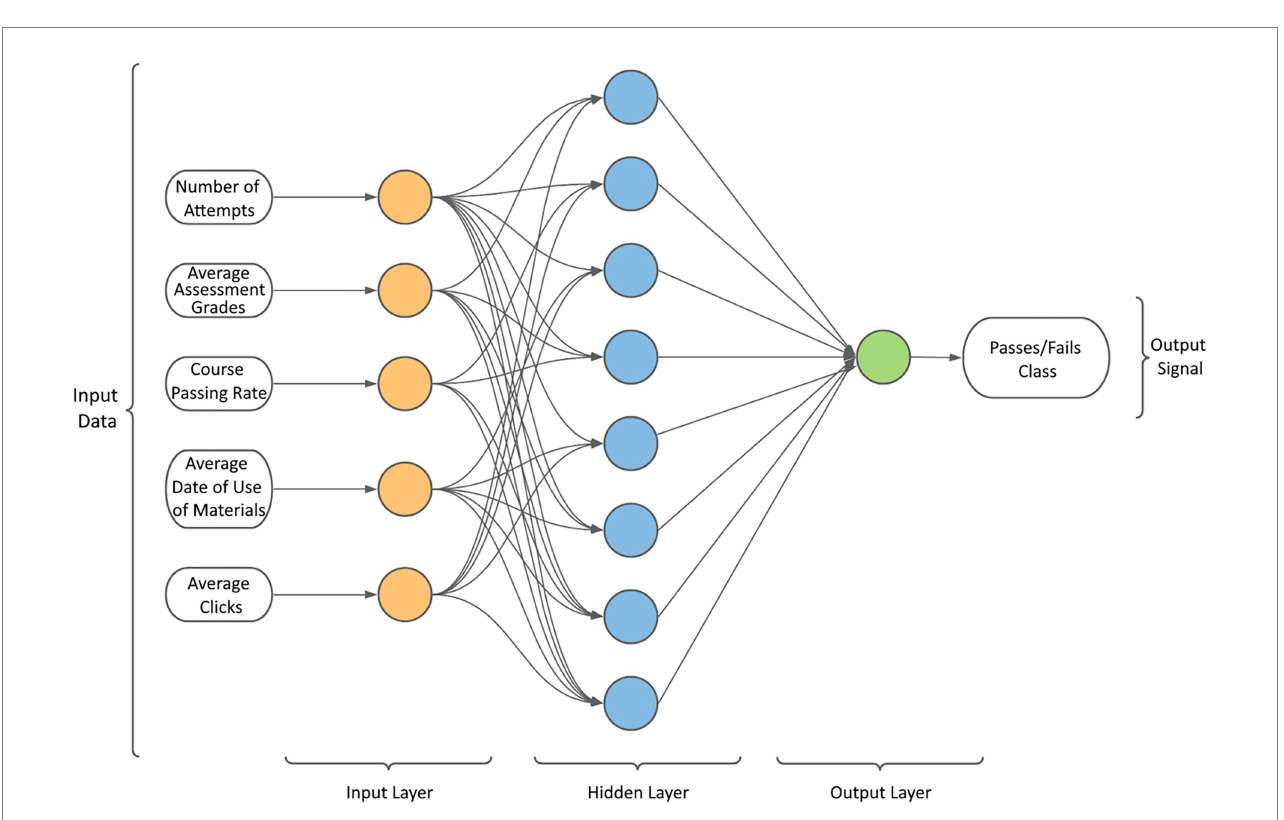
FIGURE 5 Neural network architecture